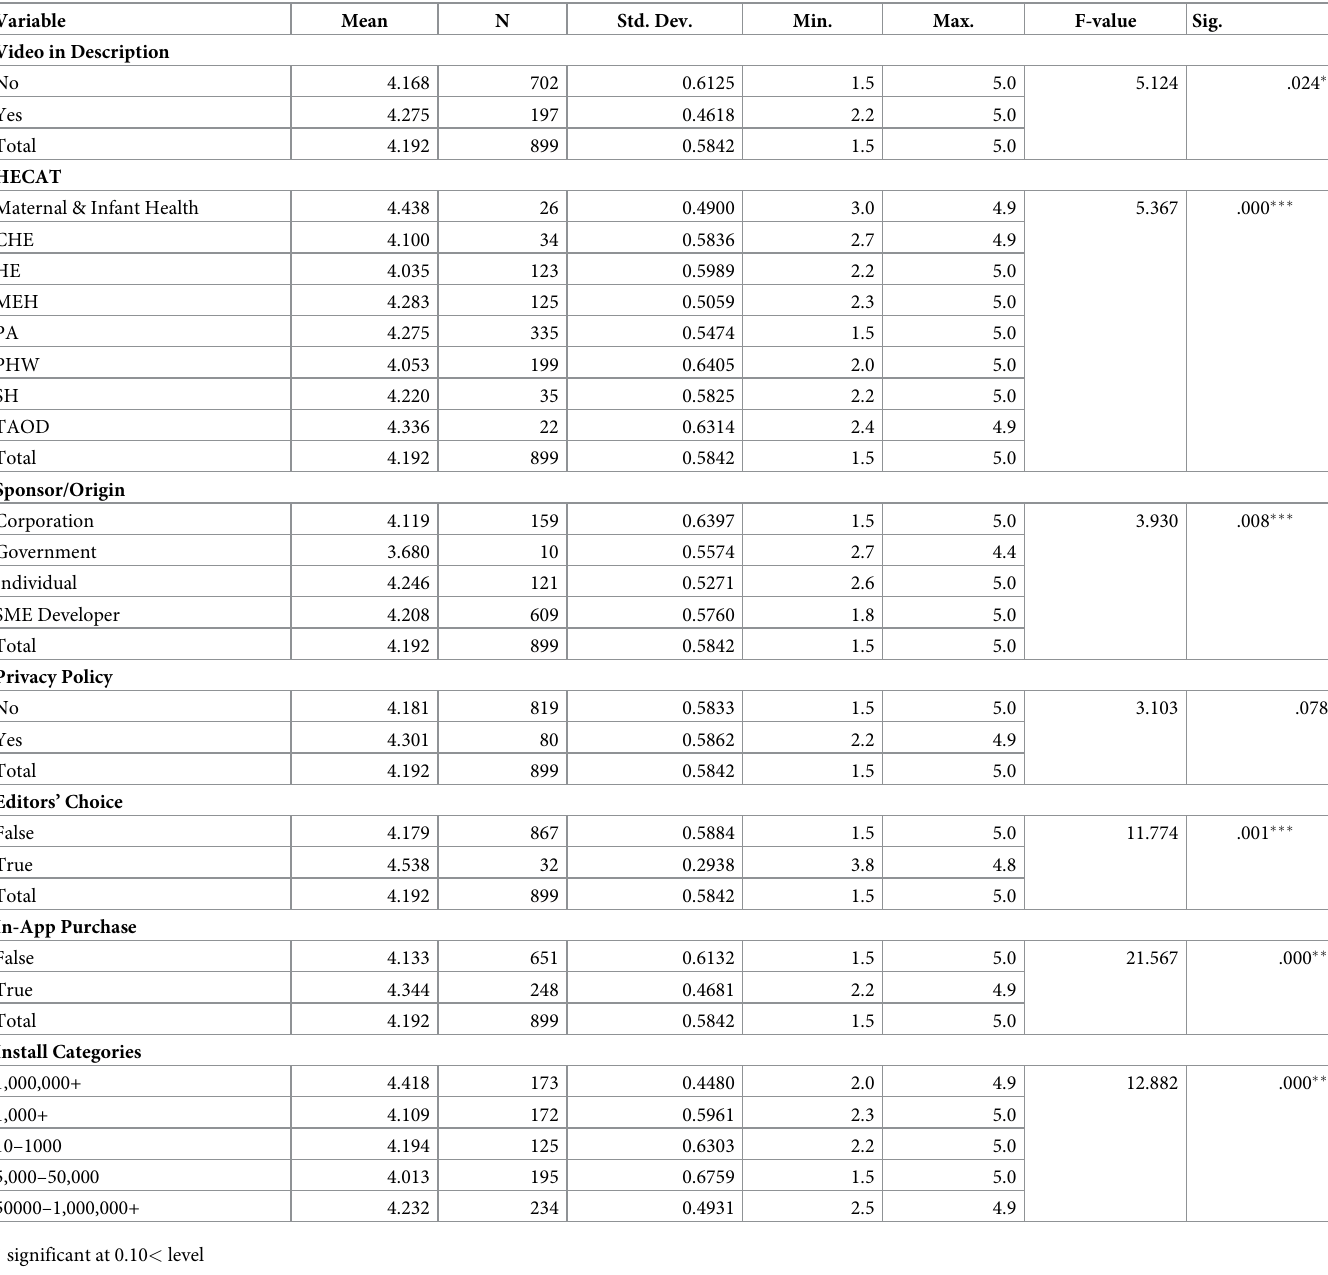
Table 3. F-test compare means